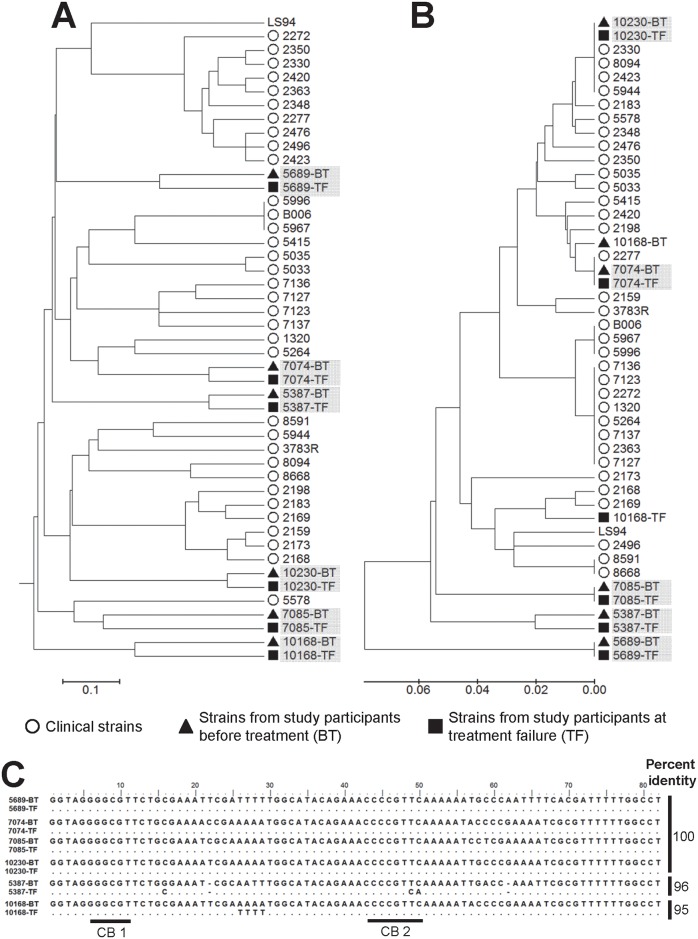
Comparative analysis of pre-treatment and post-treatment clinical strains by kDNA genotyping and multilocus microsatellite typing.UPGMA trees of distances calculated from MLMT data (A) and conserved block minicircle kDNA genotyping (B) from three pairs of L. V. panamensis and three pairs of L. V. braziliensis strains isolated before treatment (BT; black triangles) and at treatment failure (TF; black squares), alongside 34 L. V. panamensis clinical strains (open circles) and the reference L. V. panamensis strain LS94. Shadowed codes denote pairs of strains isolated from the same patient. (C) Pairwise sequence alignment of pre and post-treatment strains indicating % base-pair identity.